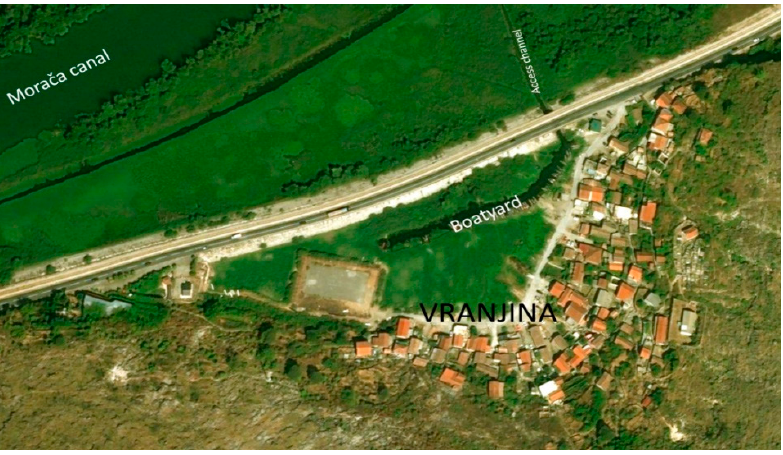
Figure 2. Sampling location, near to settlement Vranjina (fishing village), Skadar Lake. Sediment. The sediment samples were taken by Ekman dredge, from the depth of 0–20 cm, packed in plastic boxes and transported to the laboratory. Samples of Trapa natans (stems, leaves and fruits) were taken from the same locality near by the settlement of Vranjina (Skadar Lake) in an area with a high density of this aquatic plant. Plants of similar size, shape and weight were packed in polyethylene bags, saved in refrigerator 5 ± 2 °C) and transferred to the laboratory.